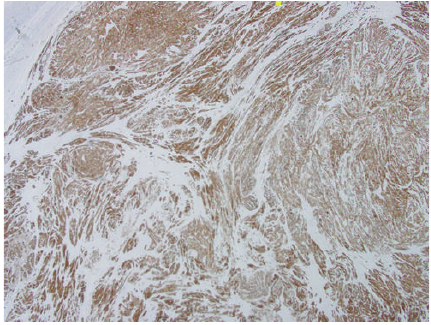
Figure 1: Laparoscopic intraoperative view of the right ovary, right tube, and part of the uterus. The right ovary is noted to be enlarged with a 5×3 cm hard mass separated from the uterus not adherent to or infiltrating the surroundings.